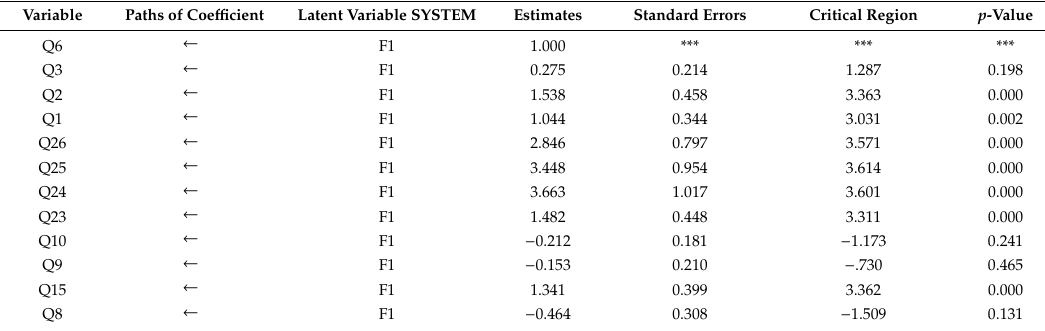
Table 4. Confirmatory factor analysis of